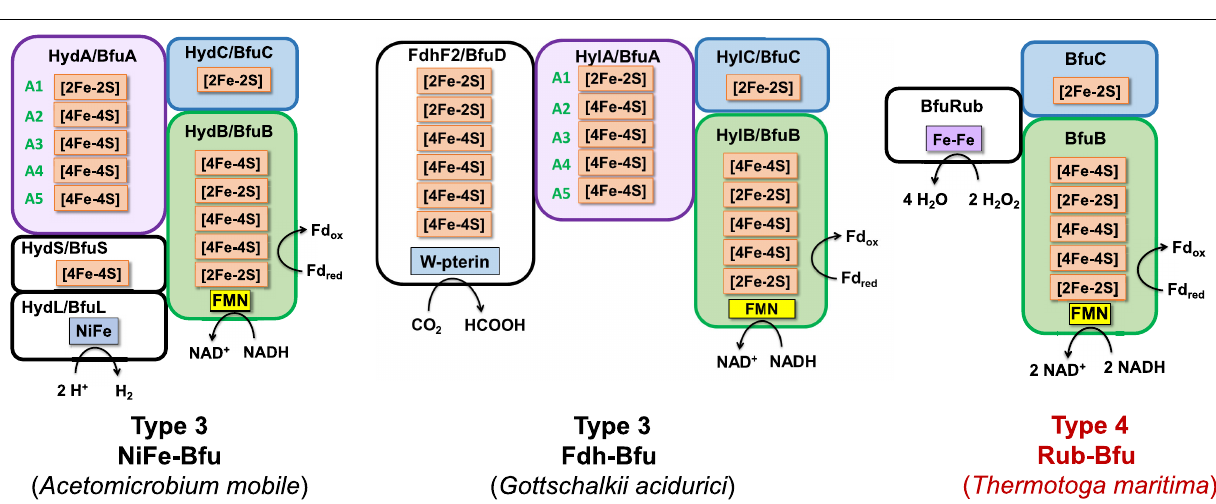
acceptor was only half of that with ubiquinone (E ◦(cid:48) = 100